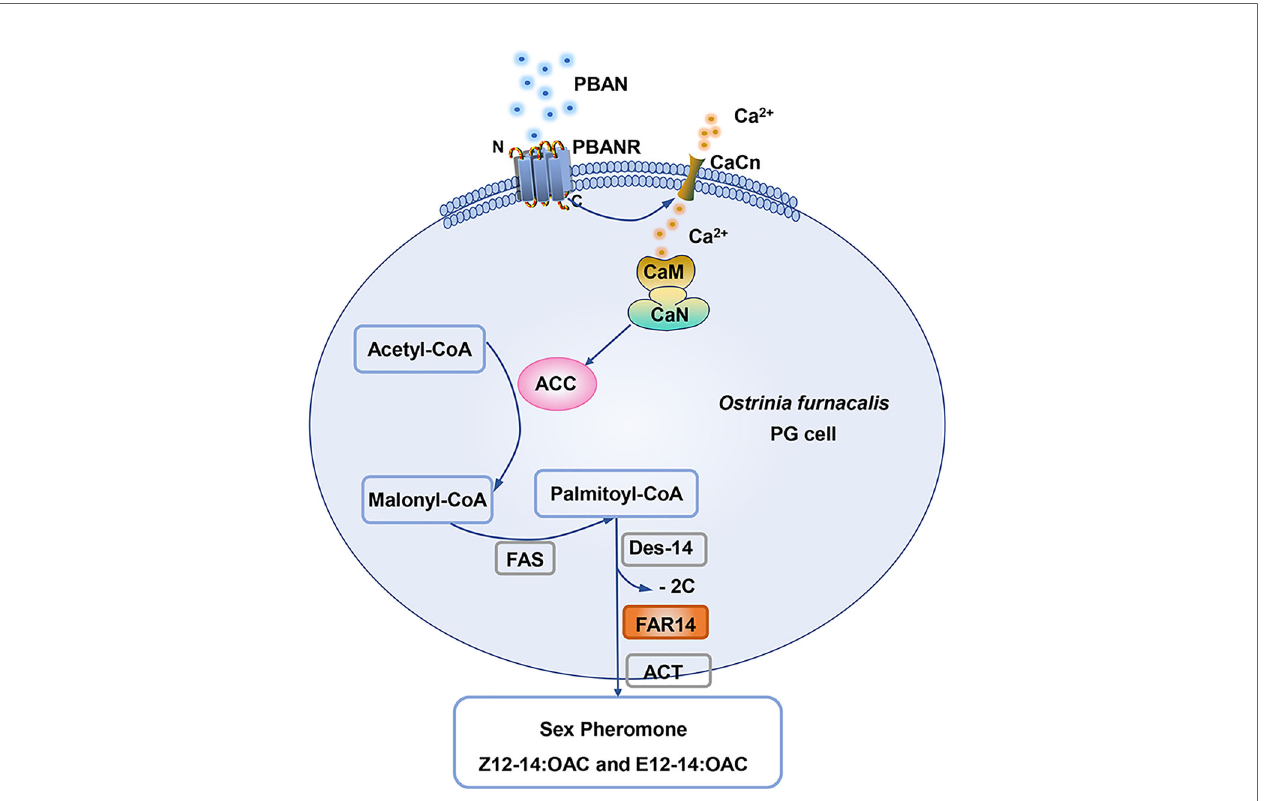
FIGURE 7 | The model of PBAN signal transduction pathway in O. furnacalis PGs. The binding of PBAN with its receptor PBANR activates the second messenger (Ca 2+ ). Ca 2+ in fl ux in turn activates CaN and ACC and ultimately regulates the production of sex pheromones under the catalysis of FAR14. PBAN, pheromone biosynthesis-activating neuropeptide; PBANR, PBANR receptor; CaCn, calcium channel; CaM, calmodulin; CaN, Calcineurin; ACC, Acetyl CoA carboxylase; FAS, fatty acid synthase; Des-14, delta 14 desaturase; FAR14, fatty acyl reductases 14; ACT, acyl